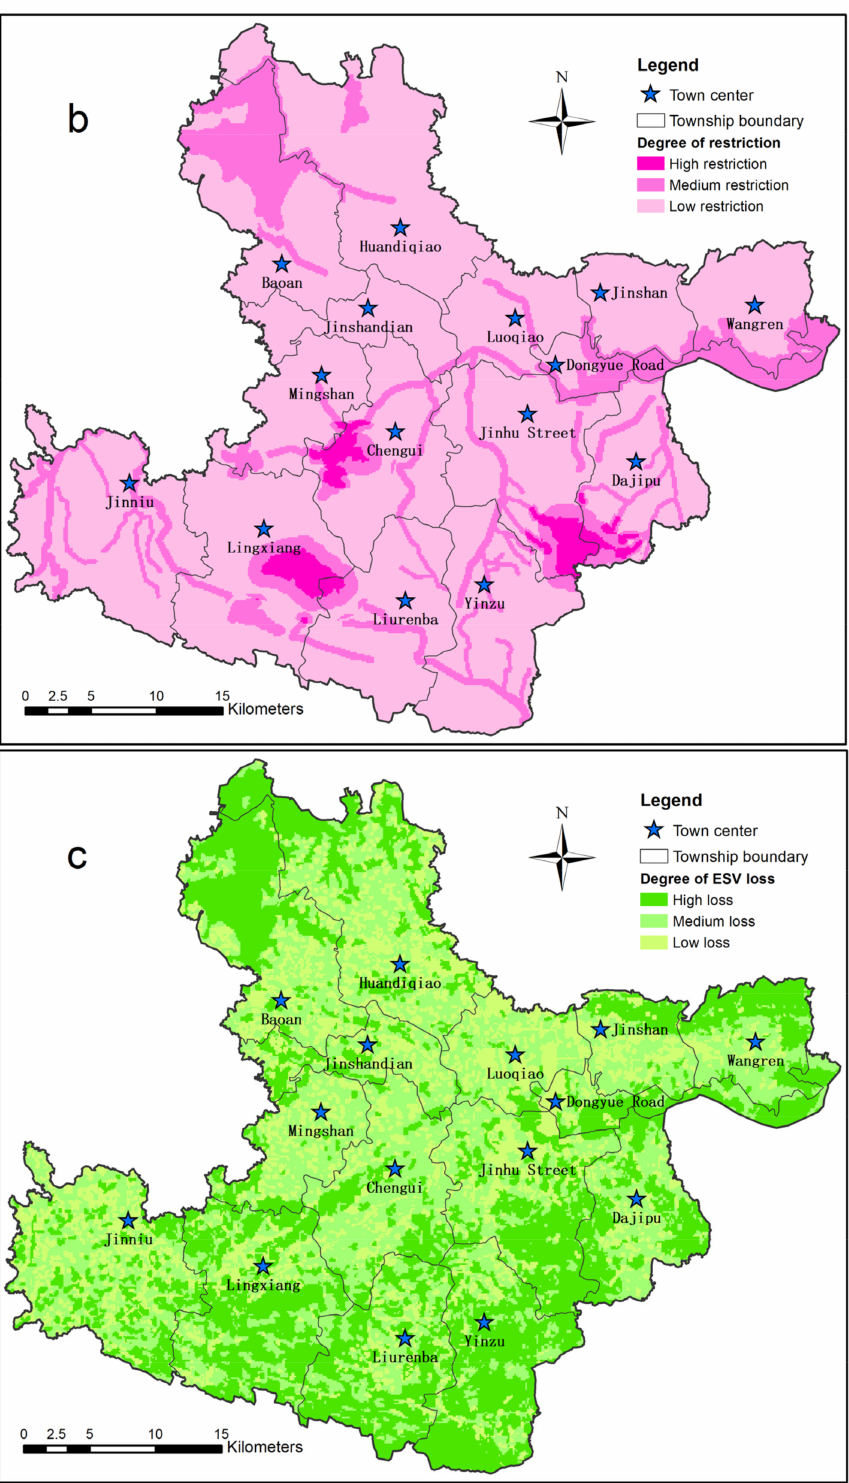
Figure 3. ( a ) The prediction result of ML, which describes the probability of LUCC. ( b ) The degree of restriction of LUCC under relevant protection policies. ( c ) The possible loss of ecosystem service value caused by